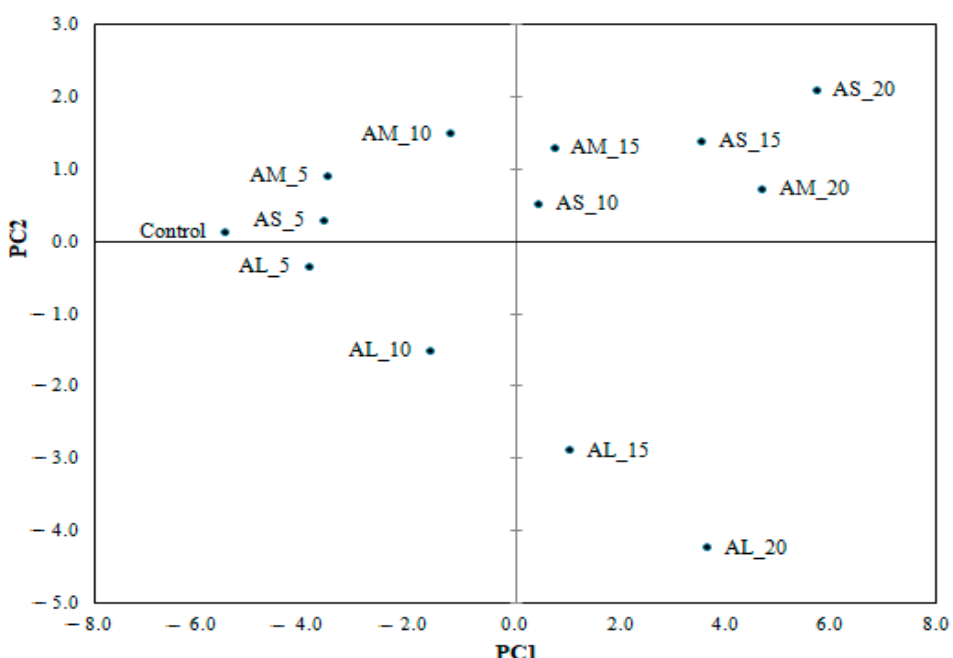
Figure 4. Principal component analysis of bread in function of the analyzed parameters as influenced by amaranth flour of large (AL), medium (AM), and small (AS) particle sizes added at 5%, 10%, 15%, and 20% compared with the control.